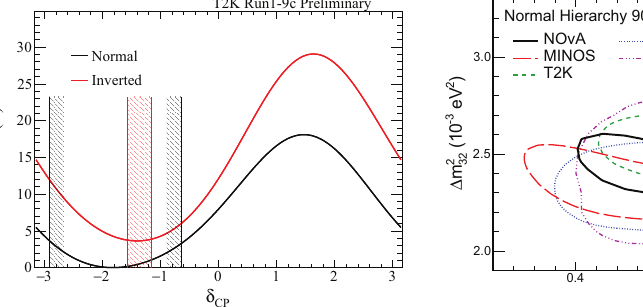
Figure 2. Two-dimensional 90% confidence level contours for ∆ m 2 vs sin 2 θ 23 of various 32 experiments [6]. The black point is the best-fit value of NO ν